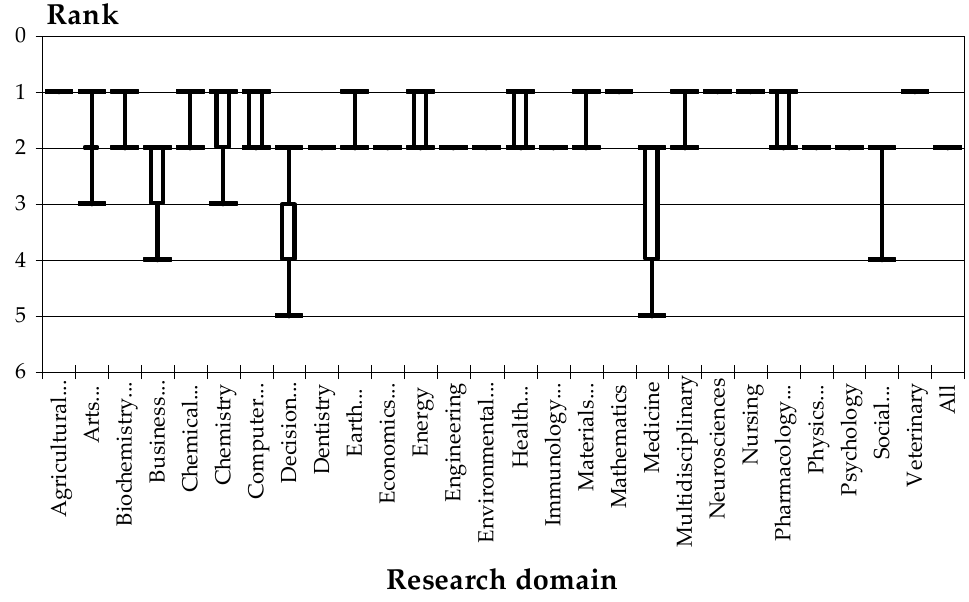
Figure 4. The number of documents published in different fields in Poland during 2010–2018. The figure displays boxplots of the ranks of fields computed for each year separately. Results indicate that the values are in the ranking’s top five.